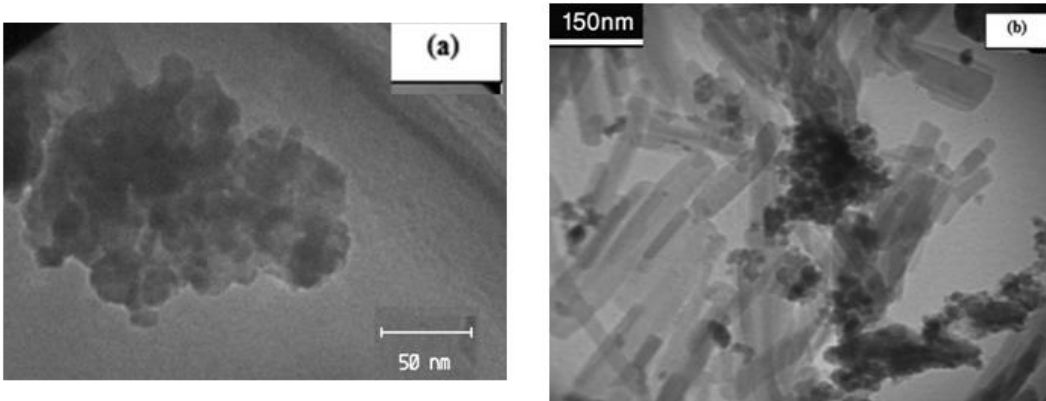
Fig. 4. TEM micrographs: (a) Cu-TiO